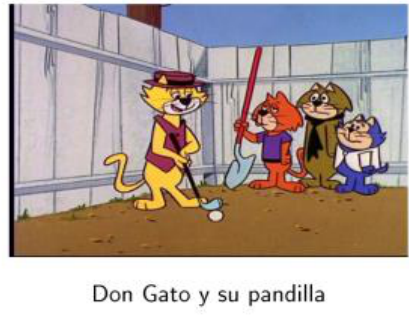
Figure 1. Stimulus from the elicitation experiment.